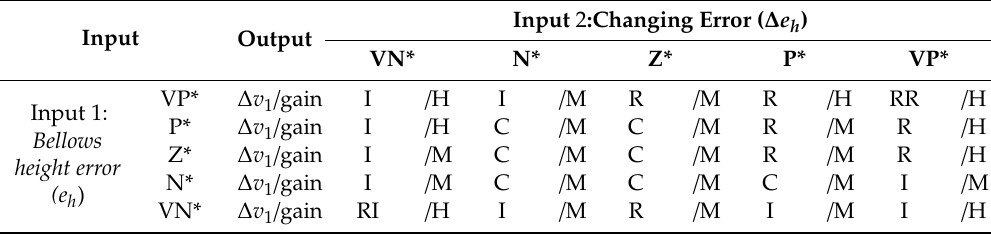
Table 4. Adaptive fuzzy rules over 50% of the bellows progress to determine the compression speed adjustment ∆ v 1 and gain. (*Refer to Figure